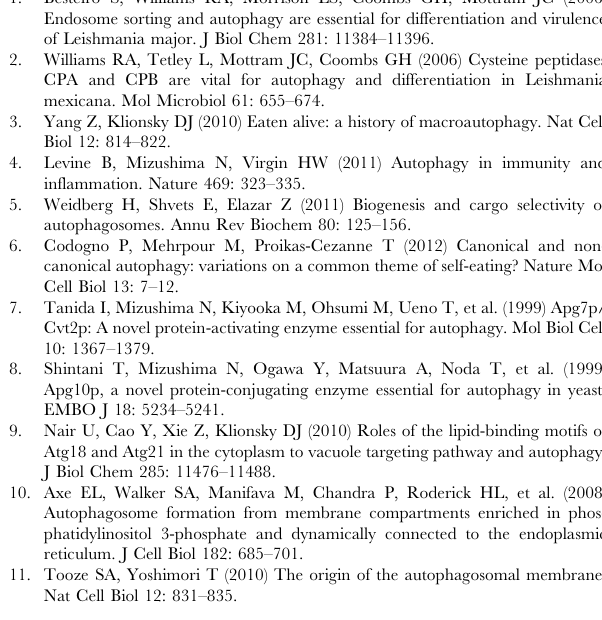
Figure S1 Generation and validation of D atg5 . (A) Schematic representation of the ATG5 locus and the plasmid constructs used for gene replacement. Arrows and boxes indicate the ATG5 and antibiotic resistance genes and the 3 9 and 5 9 flanking DNA sequences, respectively. The restriction enzymes